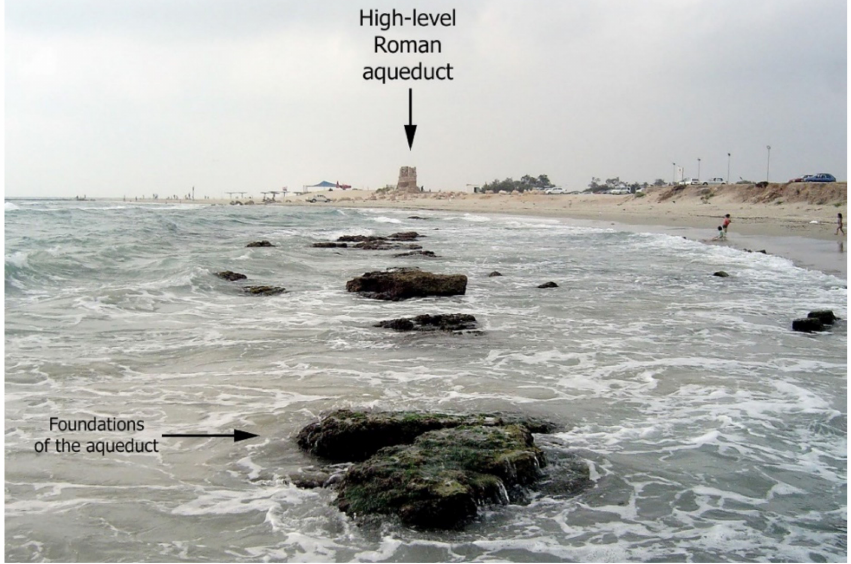
Figure 13. The remains of the aqueduct foundations after undergoing erosion in the sea and in situ on the coast, looking north (for location see Figure